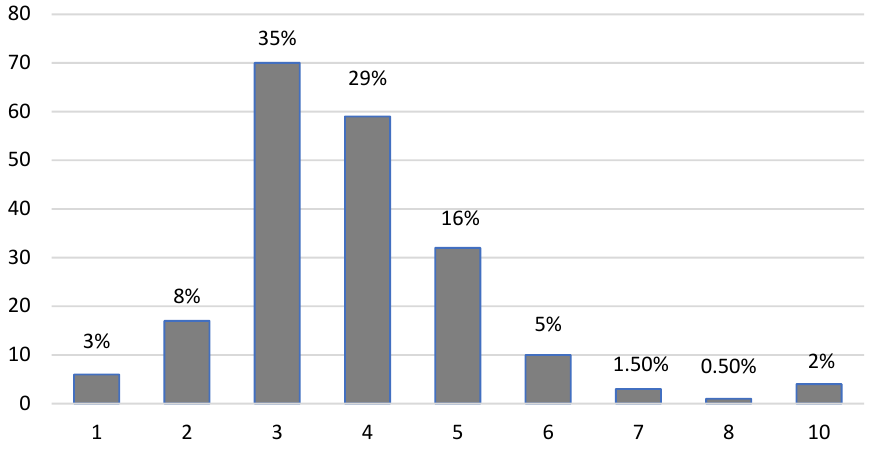
Figure 2. Chinese hosts, participants in this survey, have been living in large households (2% even with ten